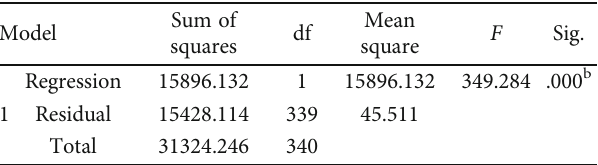
Table 7: ANOVA summary of SA and PD.